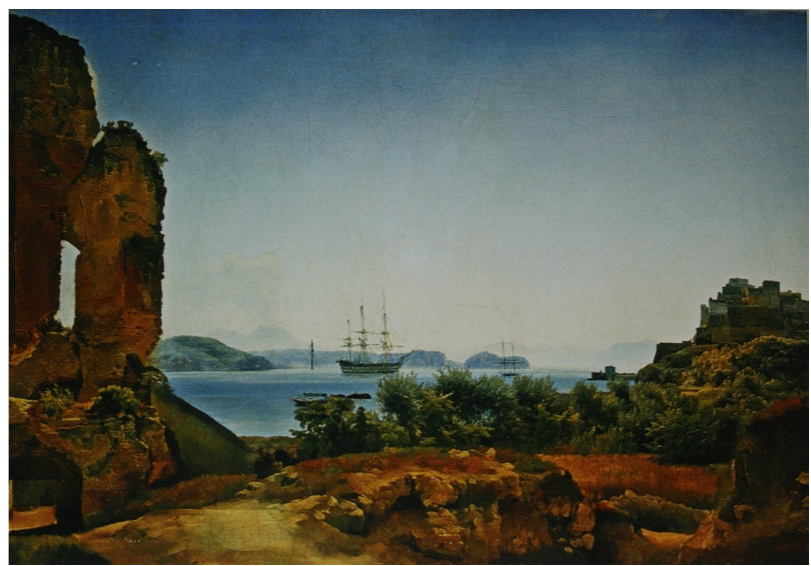
Figure 30. Hubert Robert. Ruines antiques , 1779. Musée des Beaux-Arts de Lyon, dépôt du Musée du Louvre.